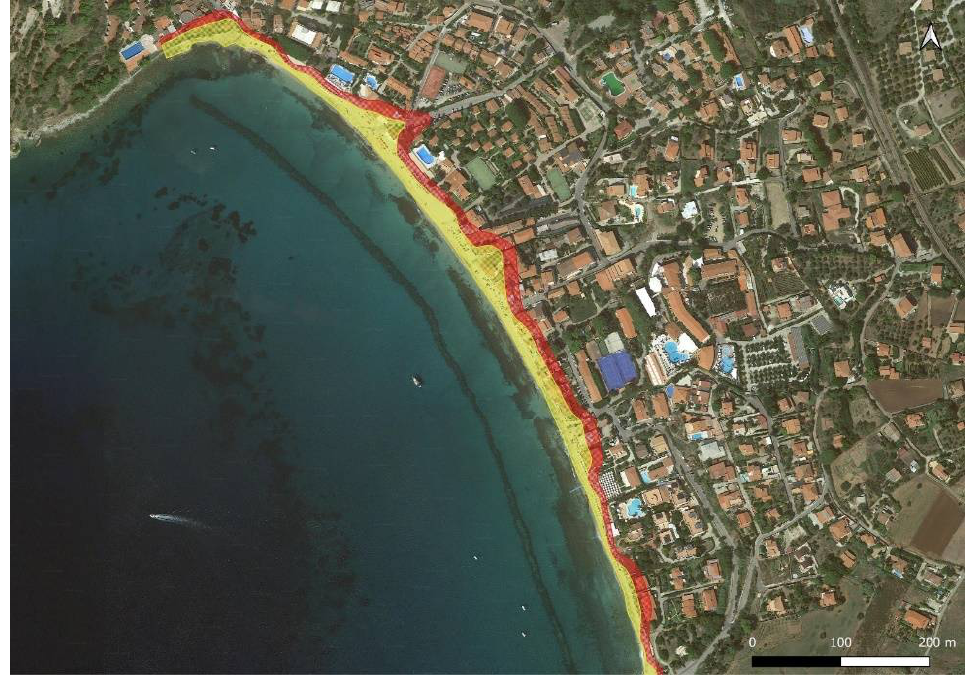
Figure 5. Ricadi. Legend: Yellow, the floodable area in the current scenario; red, the floodable area in the future scenario.